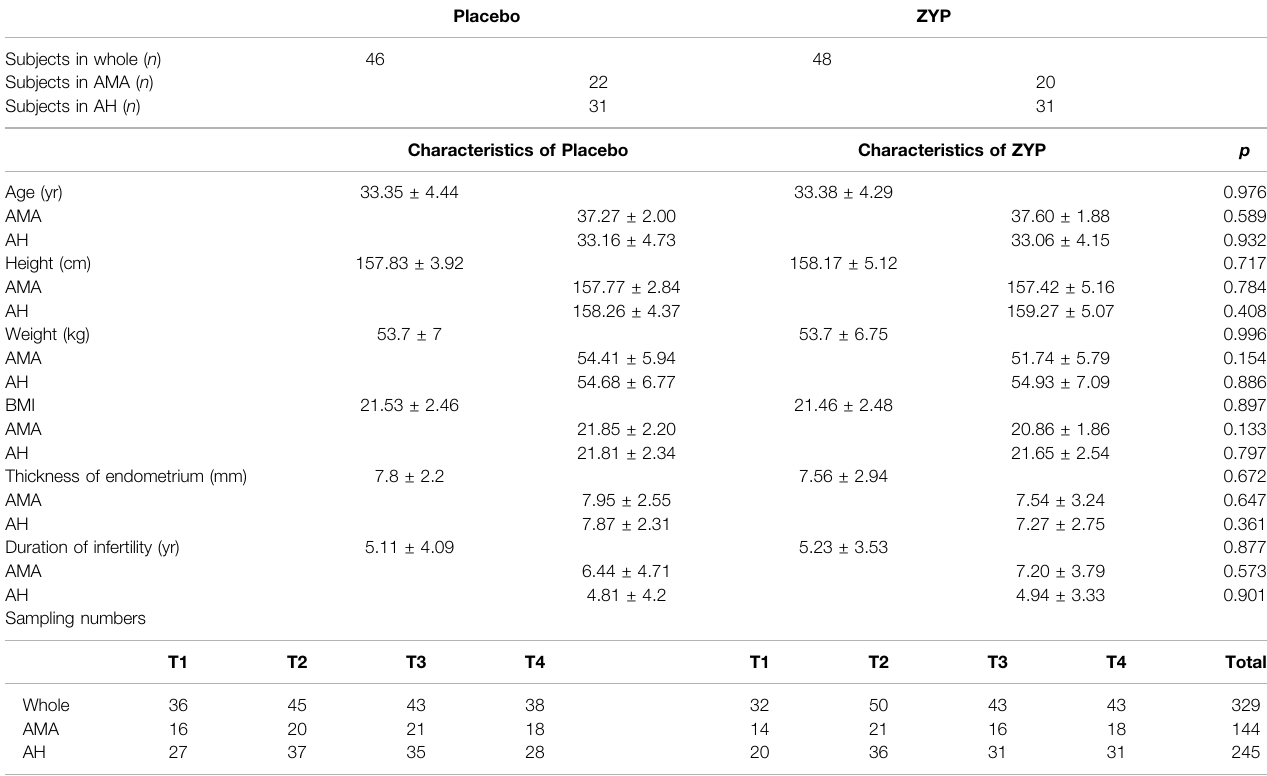
TABLE 2 | Clinical characteristic of subjects in ZYP-RCT on baseline and sample